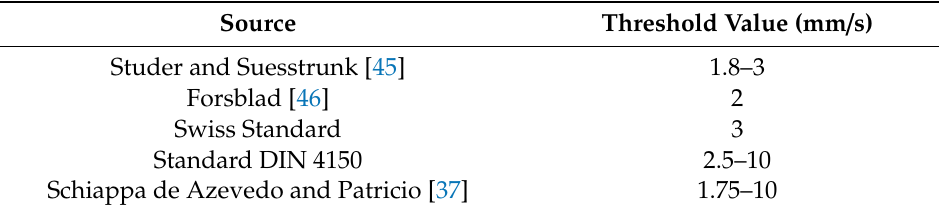
Table 1. Values stablished by di ff erent sources / authors.